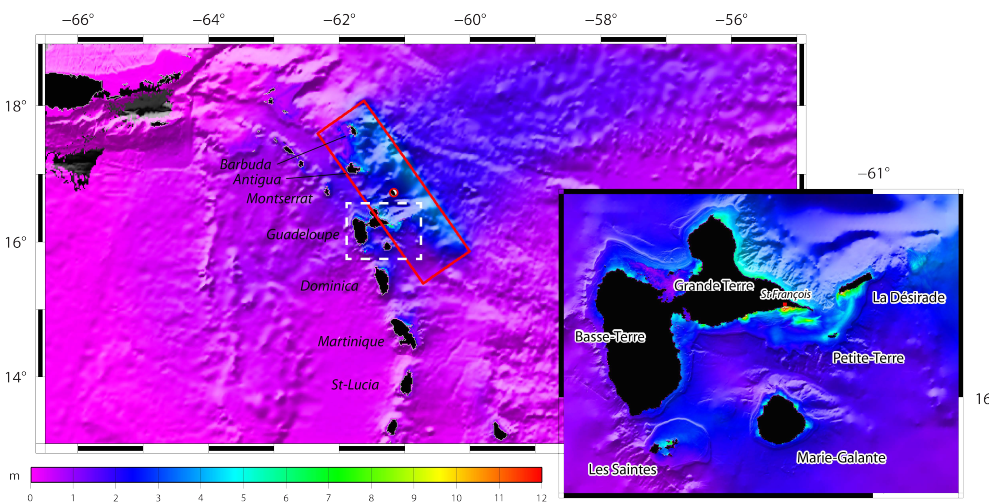
Fig. 9. Maximum wave heights illuminated by a bathymetric gradient obtained for Grid 0 and Grid 2 after one hour of tsunami propagation with the CEA code. The red rectangle symbolizes the fault plane location. The white dashed rectangle locates Grid 2 boundaries on Grid 0.